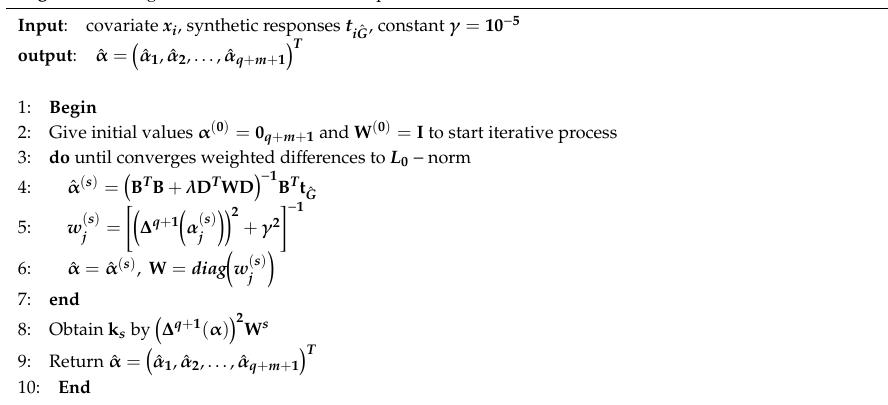
Algorithm 1. Algorithm for the modified A-spline estimator ˆ α